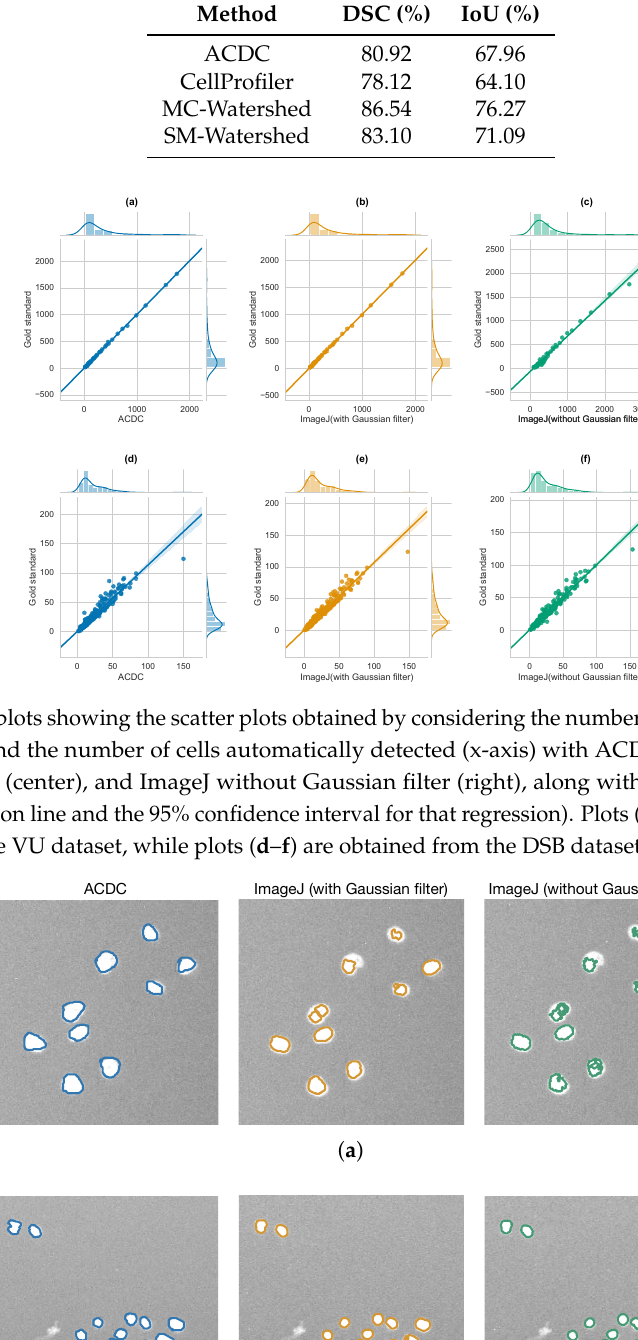
Table 3. Comparison of ACDC, CellProfiler, MC-Watershed, and SM-Watershed in terms of cell nuclei segmentation on the SNPHEp-2 dataset.